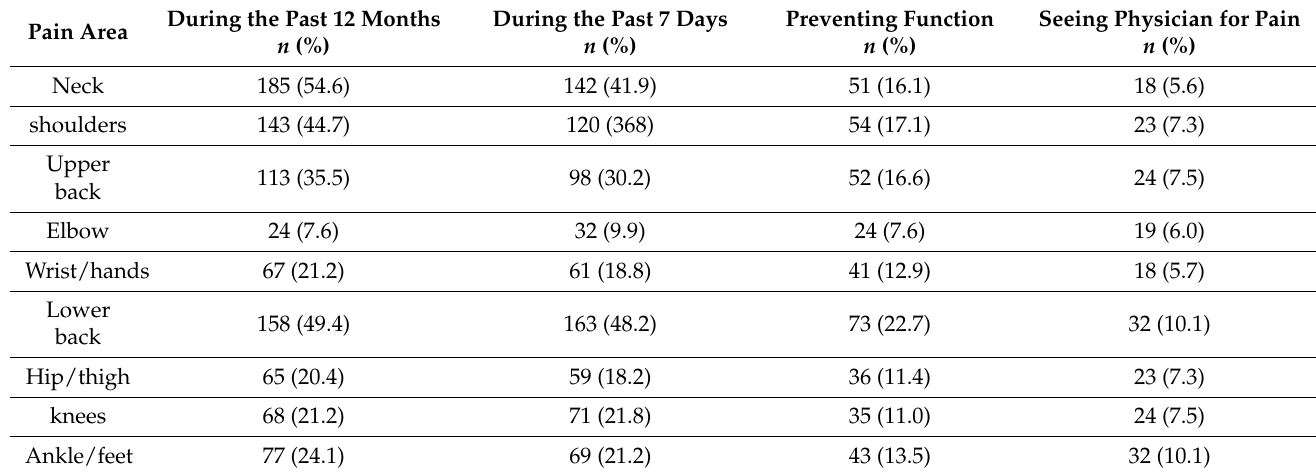
Table 3. Prevalence of MSKP in the past 12 months and 7